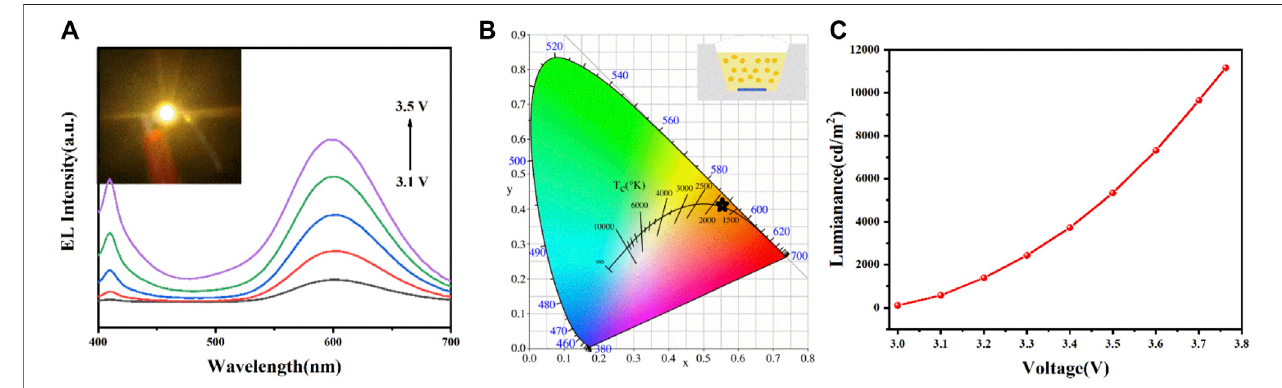
FIGURE5 |(A) EL spectra, (B) thecorrespondingCIE colorcoordinates, and (C) luminance – voltage curvesofthe LED withCPCM-TBA NCs. Insetof (A) shows a digital camera image of the working LED device and inset of (B) shows the schematic structure of the